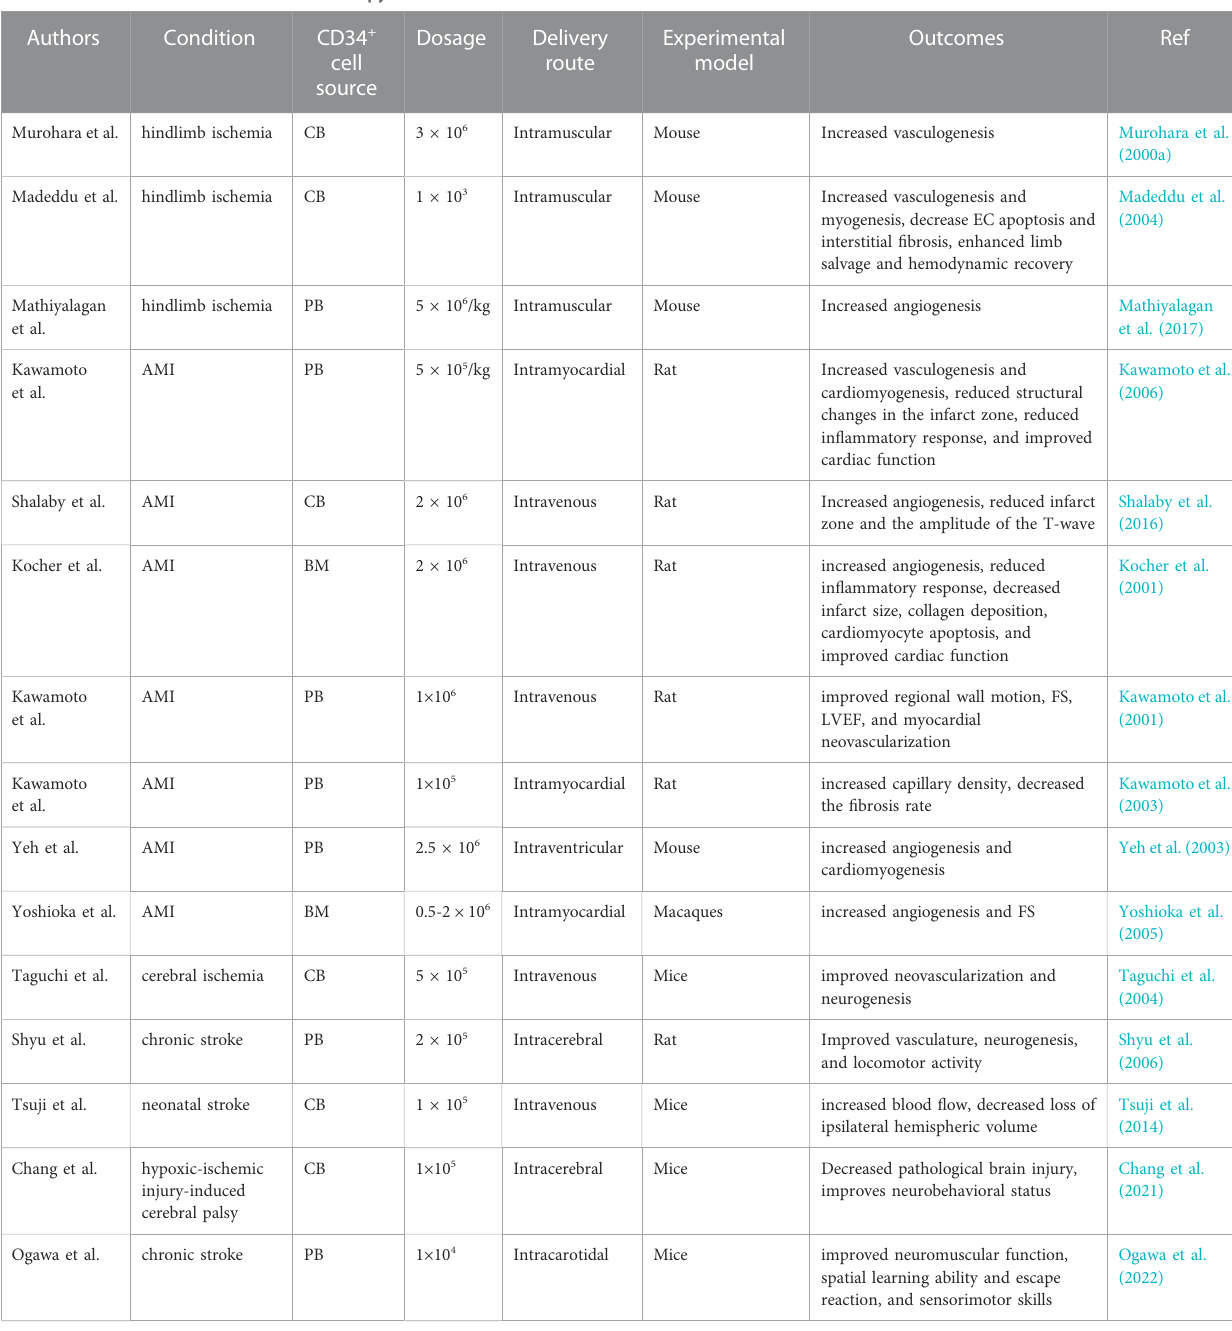
TABLE 4 Preclinical studies of CD34 + cell